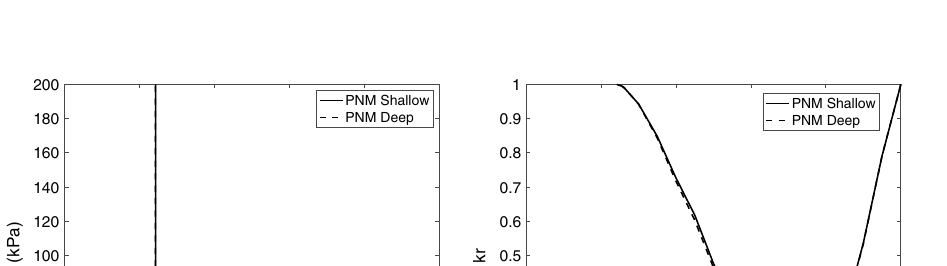
◦ ◦ , θ r = 21.56 and σ = 51 (mN/m). The base